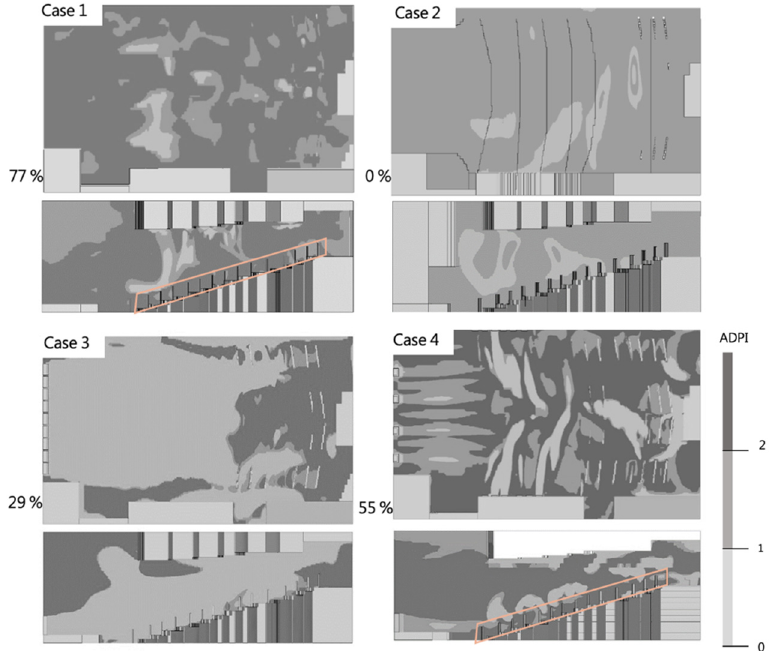
Figure 19. ADPI distribution of each case.